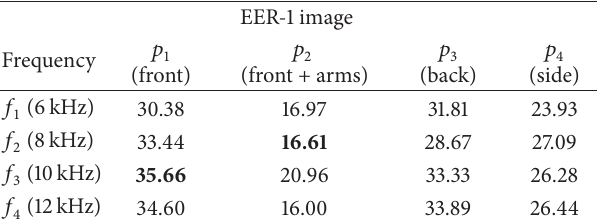
Table 3: Equal error rate using 1